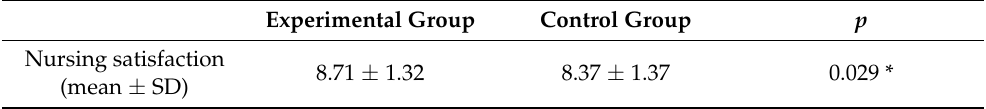
Table 4. Comparison of nursing satisfaction between the experimental group and the control group.